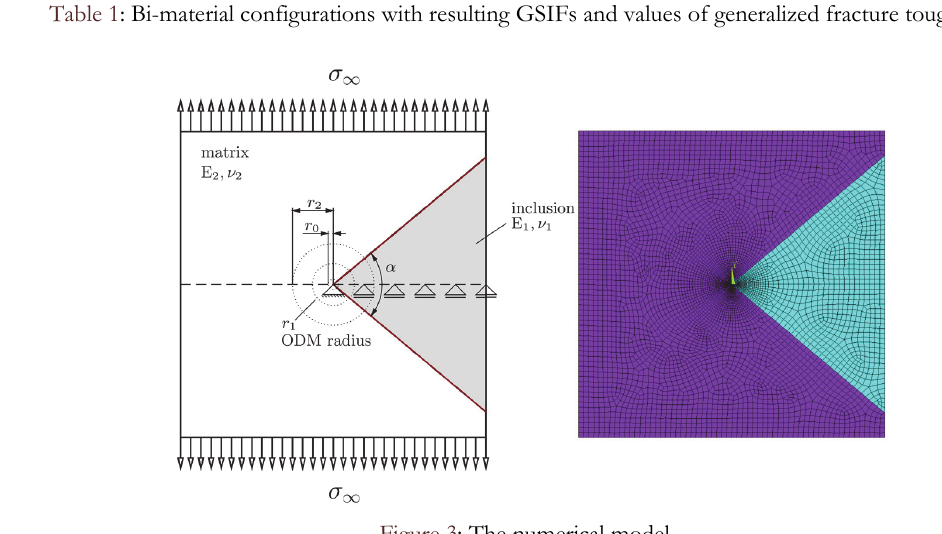
Figure 3: The numerical